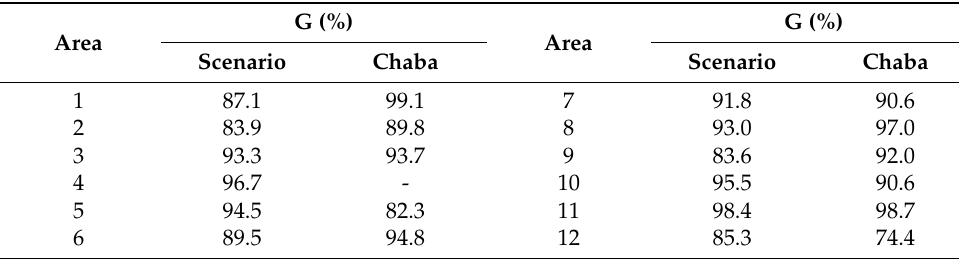
Figure 14. Comparison of inundation area (scenario). Table 3. Goodness of fit (G) of flood extent.